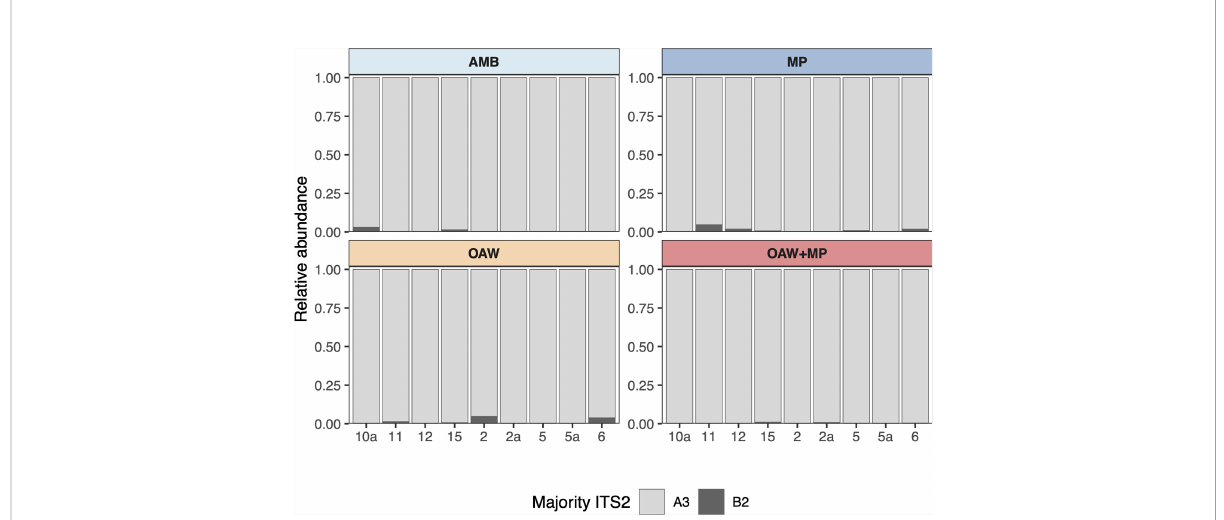
FIGURE 2 Relative abundance of major ITS2 types across each sample grouped by treatment. Light grey represents Symbiodinium ‘ fi tti ’ (A3) and dark grey represents Breviolum minutum